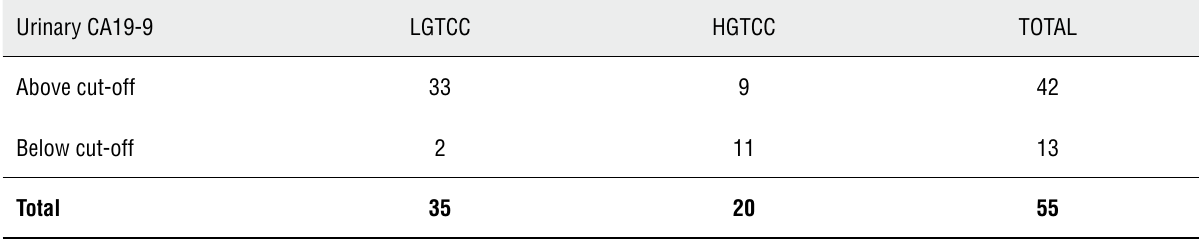
Table 3 - Comparison of urinary level of CA19-9 between low grade and high grade transitional cell carcinoma with cut-off value of urinary CA19-9 of 114.5